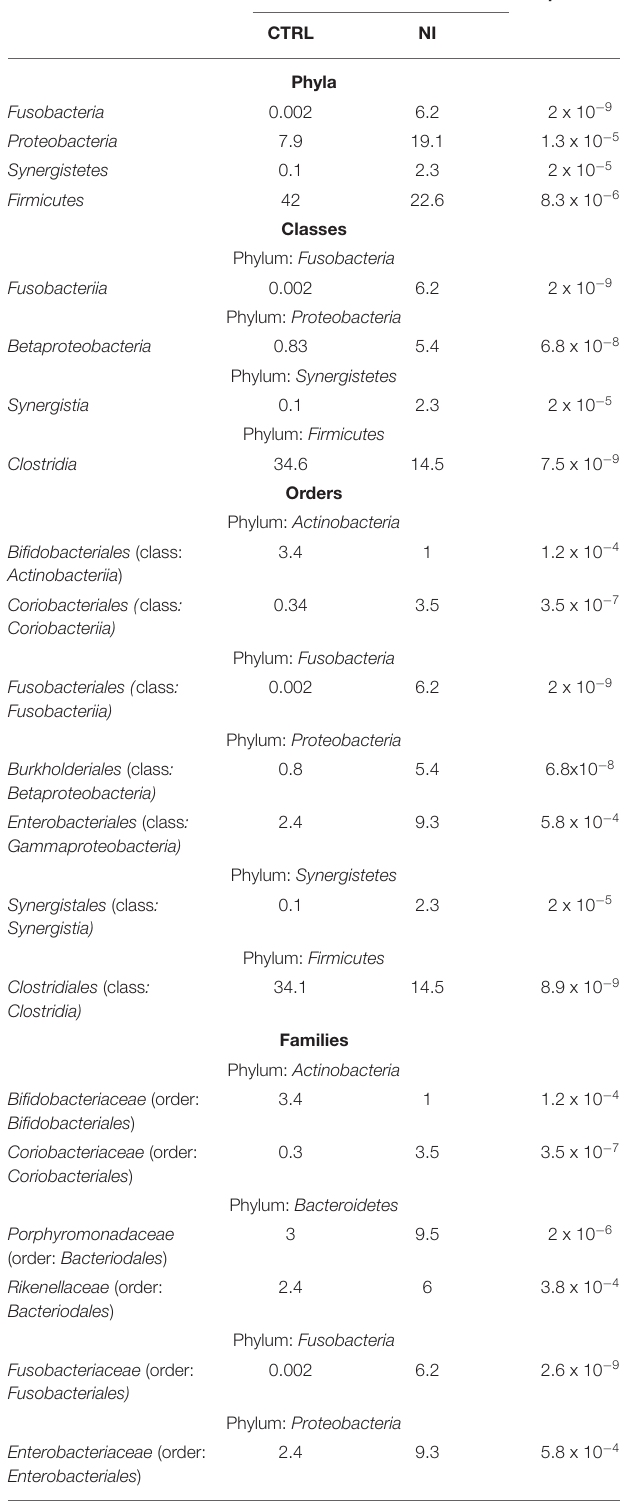
TABLE 3 | Taxa displaying significantly different relative abundances in NI and CTRL